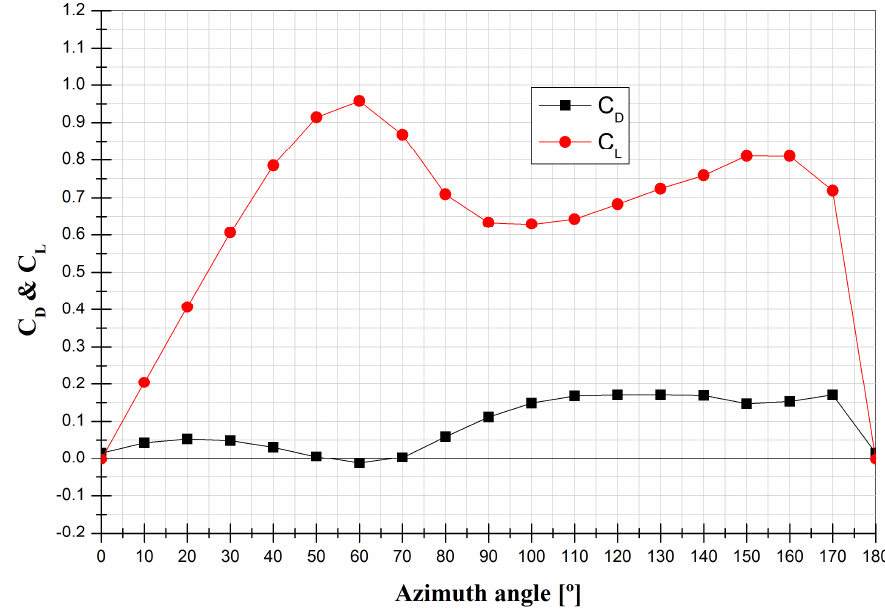
Figure 5. Lift and drag coefficient variation in a blade azimuth angle from 0° to 180° (NACA0018) calculated by 2D CFD simulation.